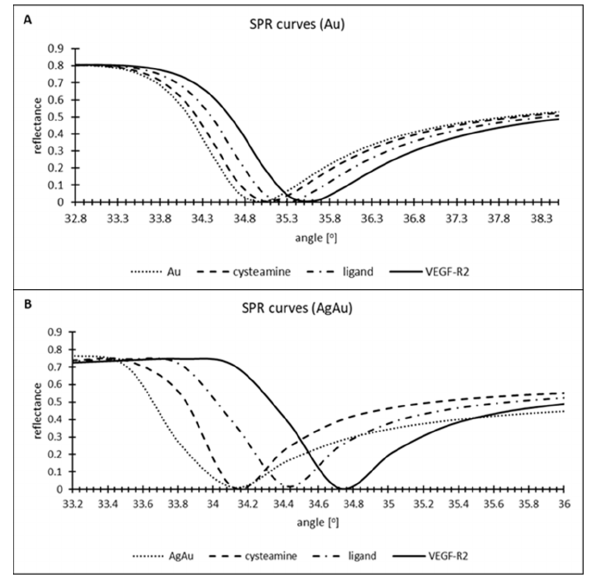
Figure 2. SPR curves plotted with WinSpall. ( A ) gold chip; ( B ) bimetallic chip.